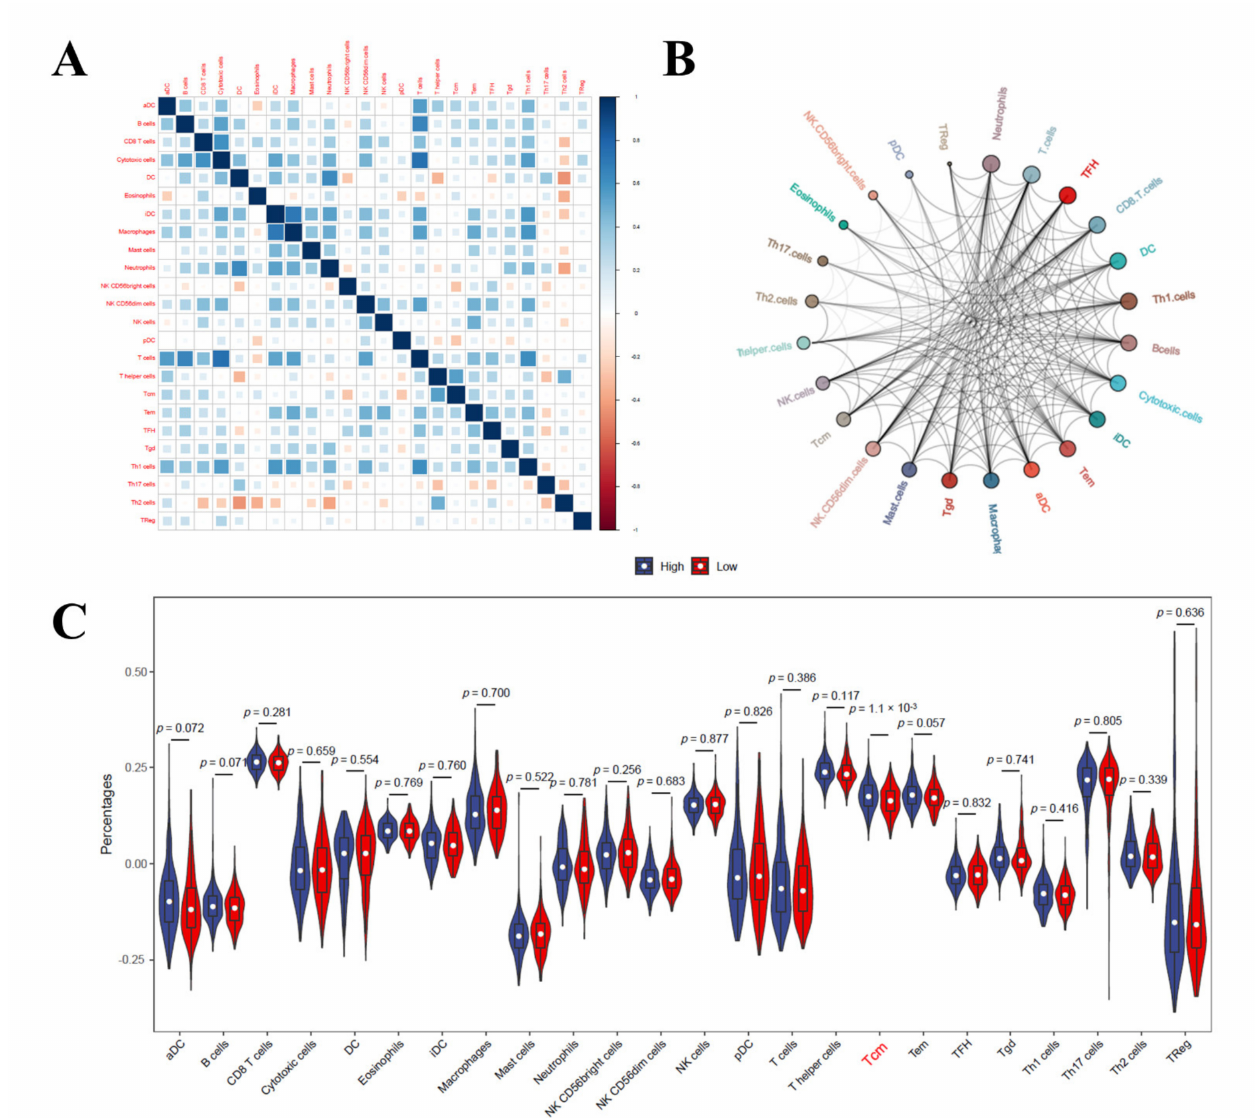
Figure 10. Correlation plots of immune cell infiltration analysis in LIHC. ( A ) Correlation heat map of 22 immune cells. Blue indicates positive correlation, red indicates negative correlation. Size of colored squares indicates strength of correlation. ( B ) Network diagram of 24 immune cell types. The circle size indicates the strength of interaction. ( C ) Violin diagram shows the difference of 24 types of immune cell infiltration in high mutation frequency of TP53 versus low mutation frequency of